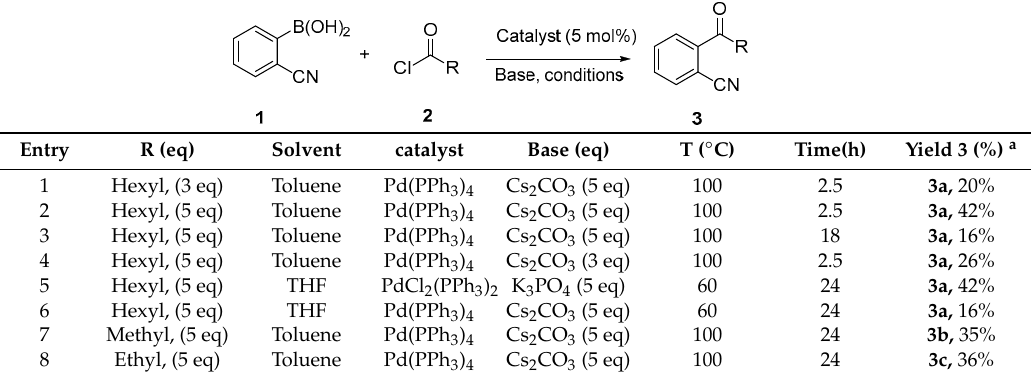
Table 1. Suzuki–Miyaura type cross-coupling reactions.